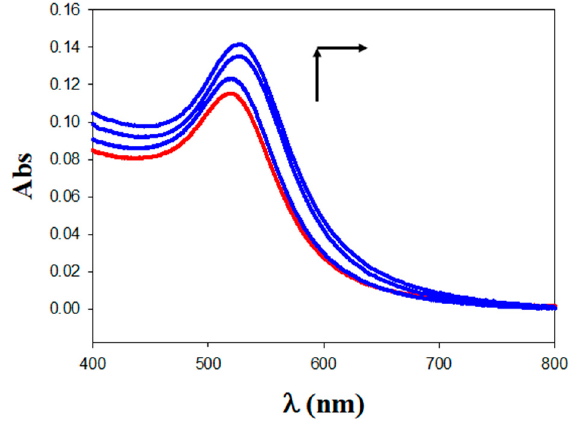
Figure 4. Absorbance spectra of nanocomplexes under different reaction conditions in a cacodylate buffer (I = 1.63 mM and pH = 7.4); C Au@16-Ph-16 = 5.6 mM in all the spectra. C DNA = 0 M (in red; Au@16-Ph-16), X = C 5-Fu /C DNA = 0.84, and C DNA = 1.0, 10.0, and 100.0 µM arrow change (in blue;